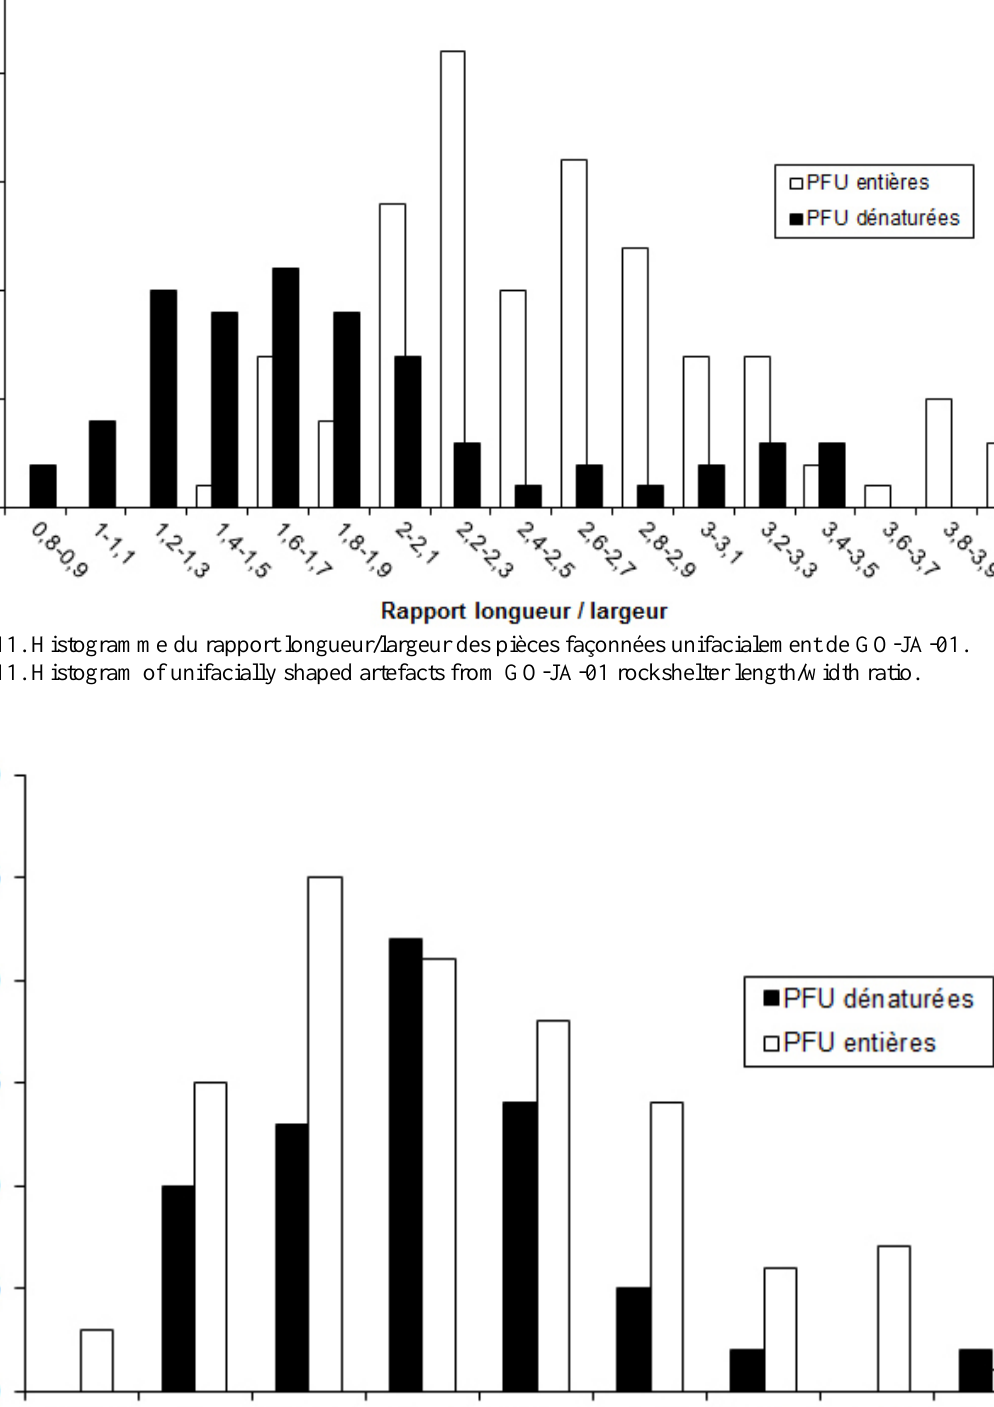
Journal of Lithic Studies (2017) vol. 4, nr. 2, p. xx-xx doi:10.2218/jls.v4i2.2548